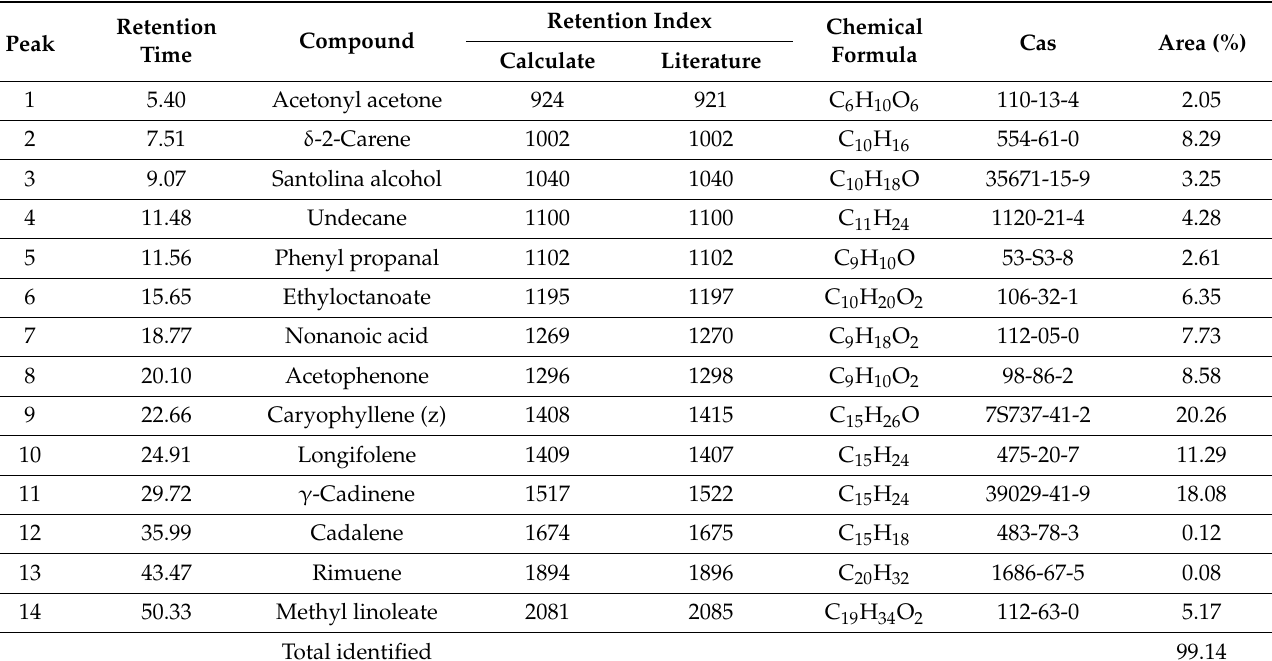
Figure 1. Chromatographic profile of EOW analyzed by GC/MS. Table 1. Identification of phytochemicals in EOW by GC/MS.